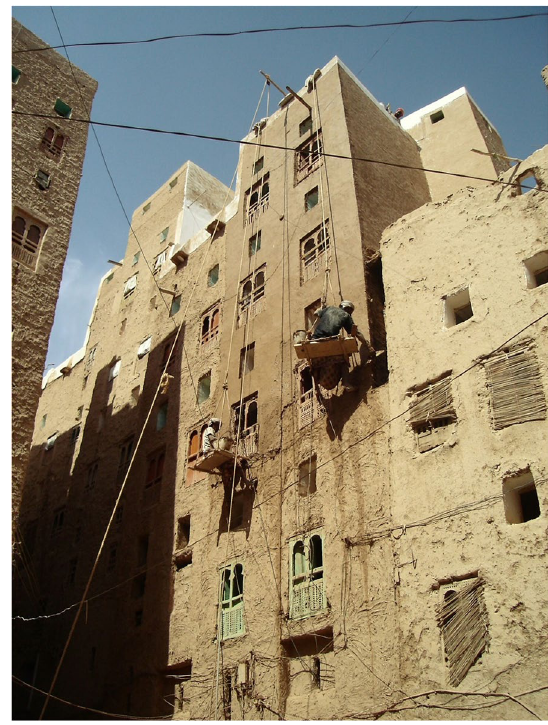
Fig. 3 Shibam, renovation of an earthen tower house (Source: the